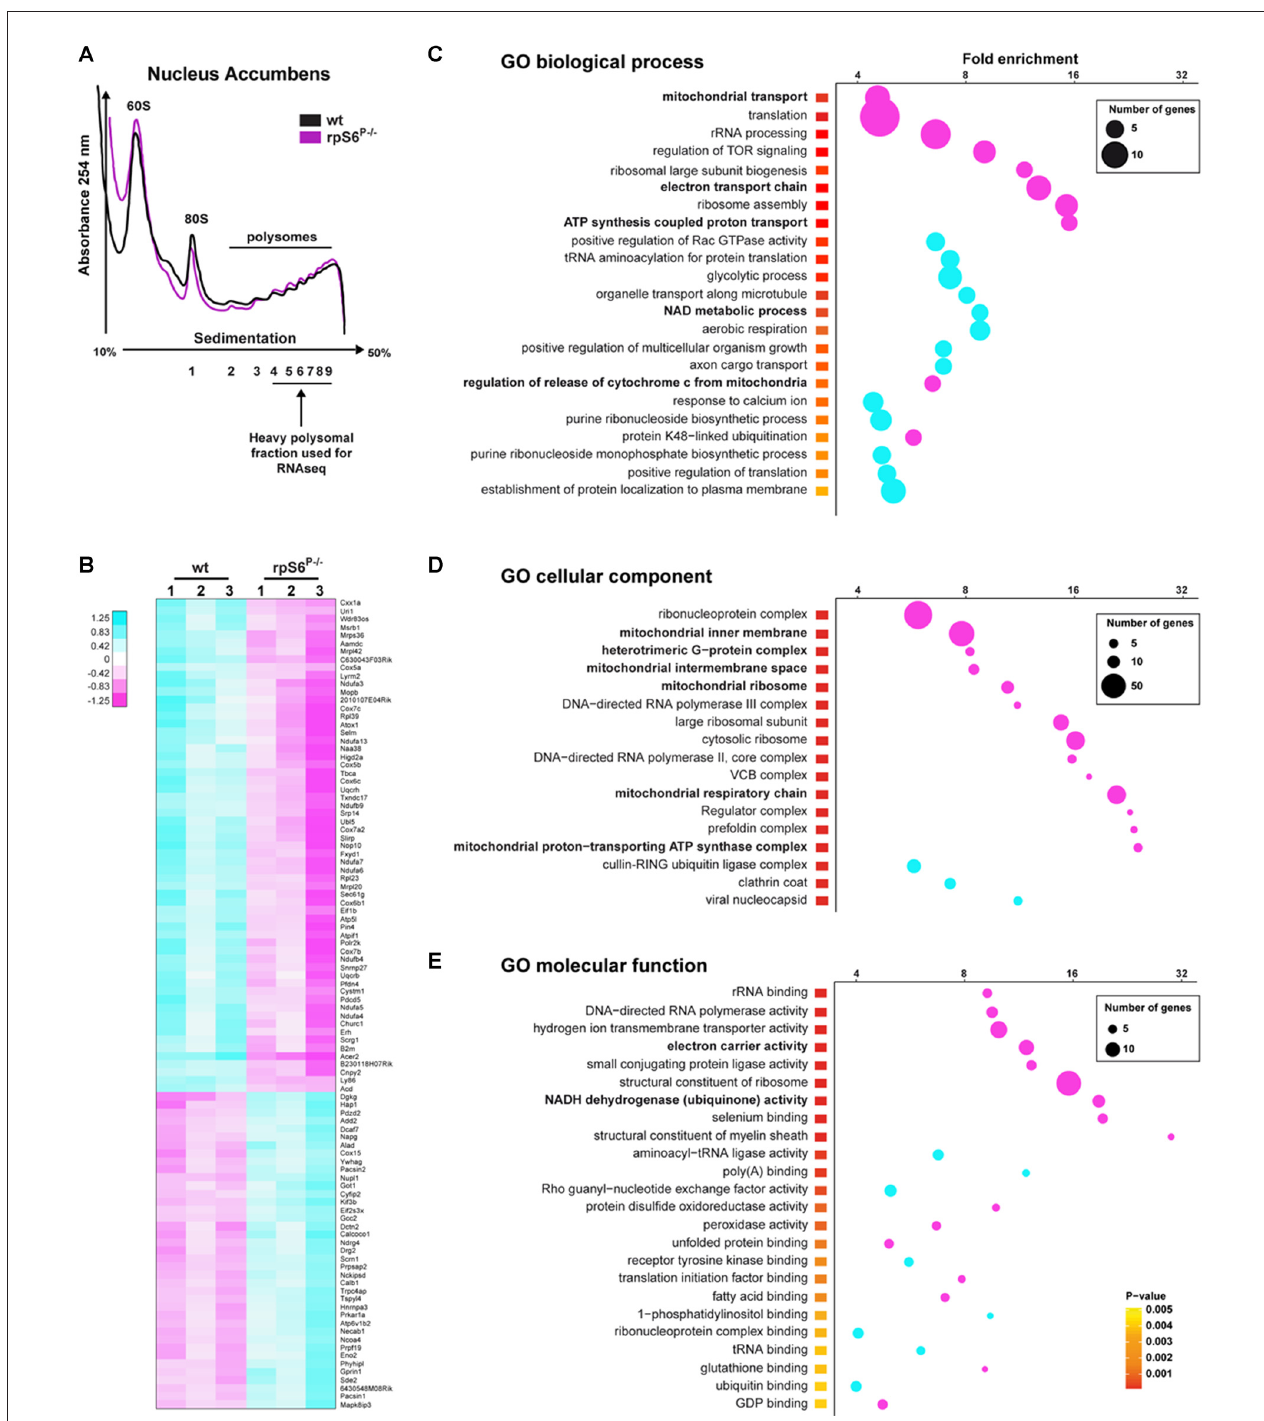
FIGURE 5 | Altered translation status of a subset of mRNAs in the Acb of rpS6 P − / − mice. (A) Representative polysome profile of Acb lysates from wt (black line) and rpS6 P − / − (magenta line) mice (top) and schematic representation of the polysomal fractions analyzed by RNAseq (bottom). (B) Heatmap of the top 100 genes most significantly dysregulated by RNAseq between Acb polysomal fractions of rpS6 P − / − mice and wt littermates (3 replicates/genotype, 6 mice/replicate). Scaled expression values are color-coded according to the legend. (C–E) Enriched terms of Gene Ontology (GO) analyses including biological process (C) , cellular component (D) , and molecular function (E) of mRNAs whose expression is significantly changed between wt and rpS6 P − / − mice in polysomal fractions from Acb extracts. The fold-enrichment (cutoff > 4) is displayed for each GO terms using Fisher’s exact test (see “Materials and Methods” section). The size of the dots is proportional to the number of genes associated with a given GO